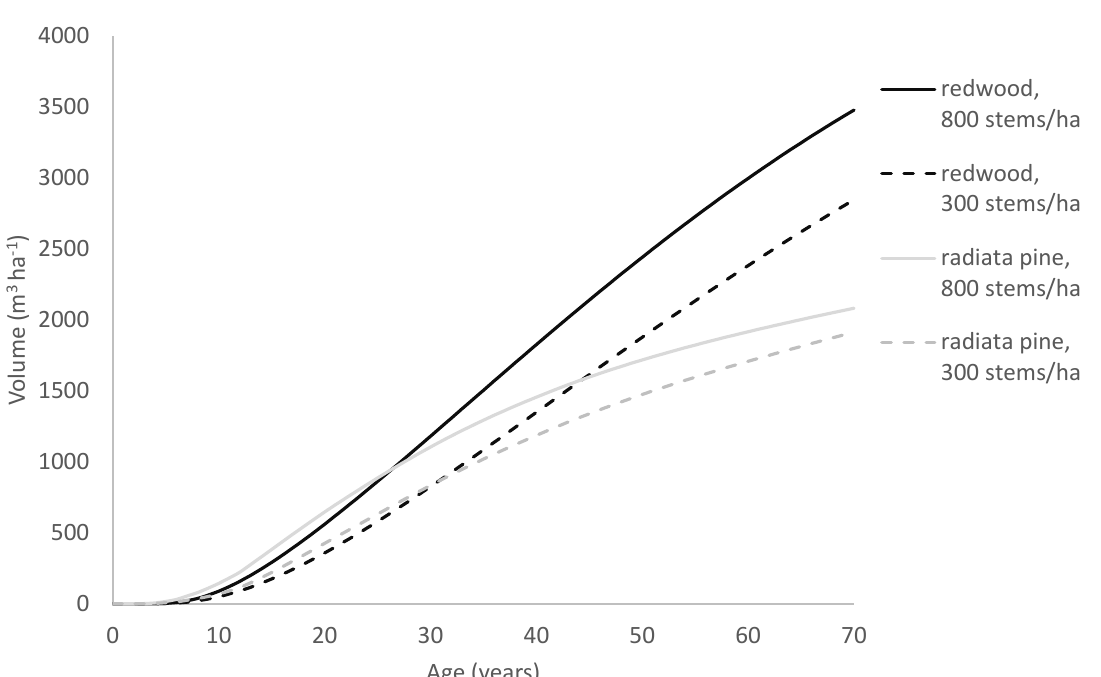
Figure 9. Stem volume predictions from the 300 Index growth models for redwood and radiata pine at 800 and 300 stems ha − 1 for a typical New Zealand North Island site with 300 Index = 27.5 m 3 ha − 1 yr − 1 for both species.